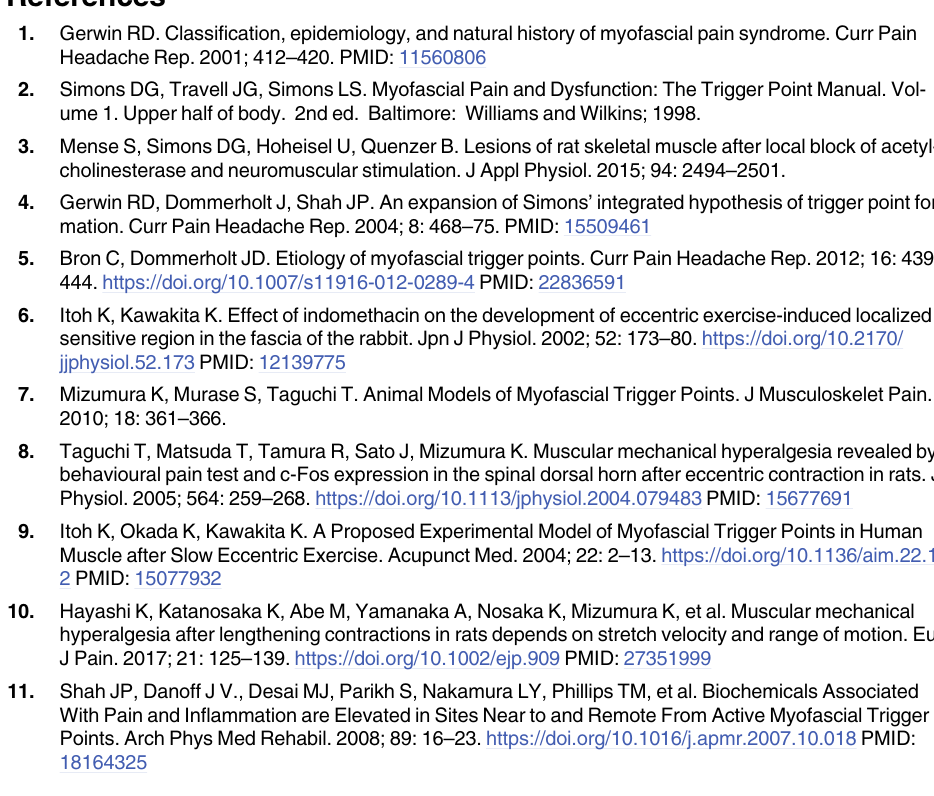
S4 Table. Area under the curve in NSAIDs, acetaminophen and vehicle group.